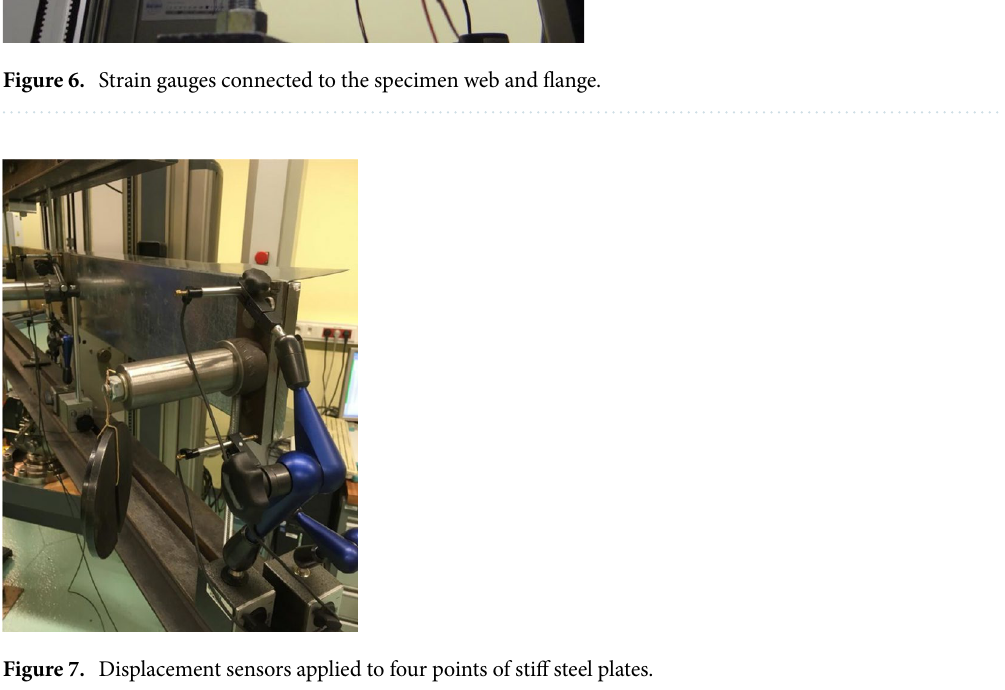
Figure 7. Displacement sensors applied to four points of stiff steel plates.